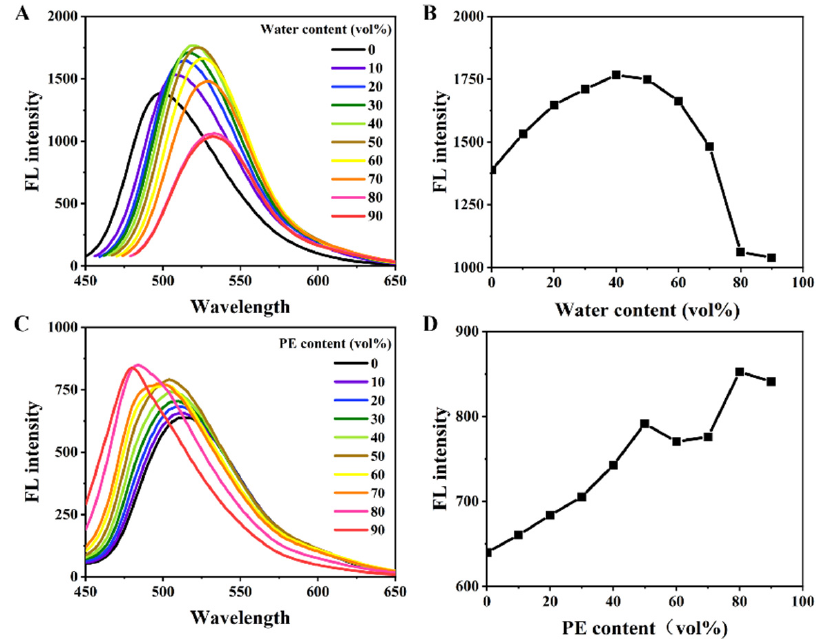
Figure 2. ( A ) Fluorescence spectra and ( B ) change in fluorescence intensity of BNEA in THF-H 2 O mixture solution. ( C ) Fluorescence spectra and ( D ) change in fluorescence intensity of BNEA in DCM-PE mixture solution ( λ ex = 430 nm, [BNEA] = 20 µ M).